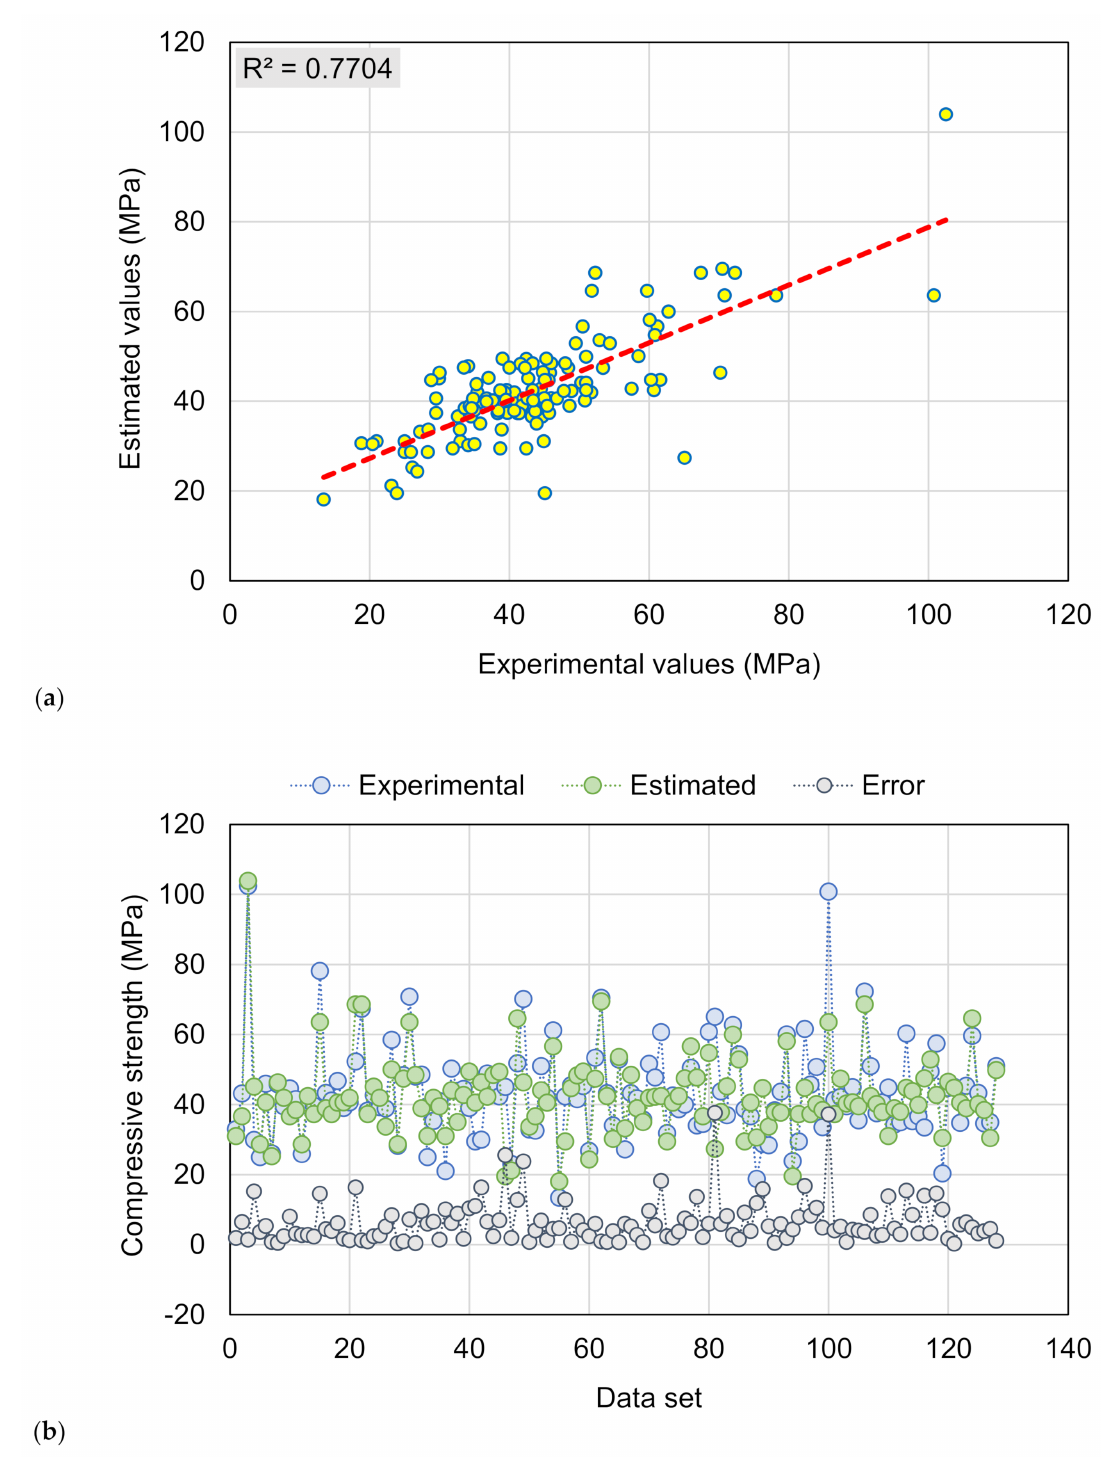
Figure 6. DT model: ( a ) Link among experimental and projected outcomes; ( b ) Scattering of actual and predicted